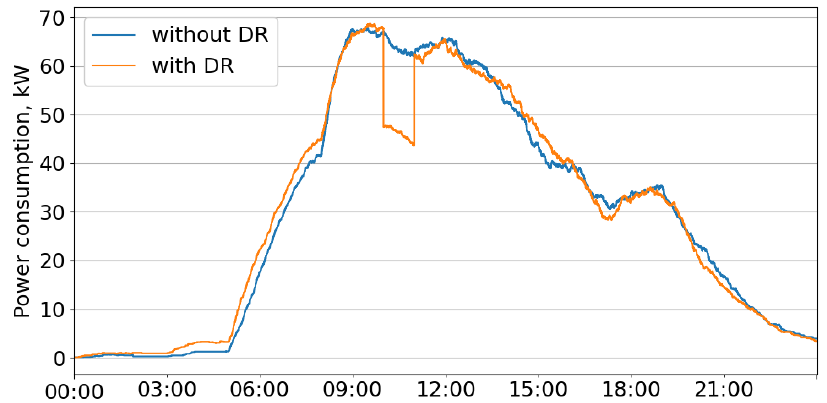
Figure 10. An illustration of the average aggregated load profile for scenarios with and without adjusting the maximum charging power of all chargers in 100 iterations, 8 chargers 11 kW each, 40 daily events.